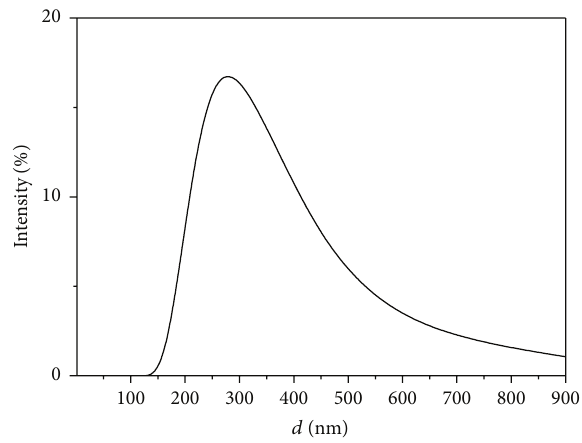
Figure 3: The curve of SiO 2 nanoparticles distribution in size in absolute ethanol (according to dynamic light scattering spec- troscopy).